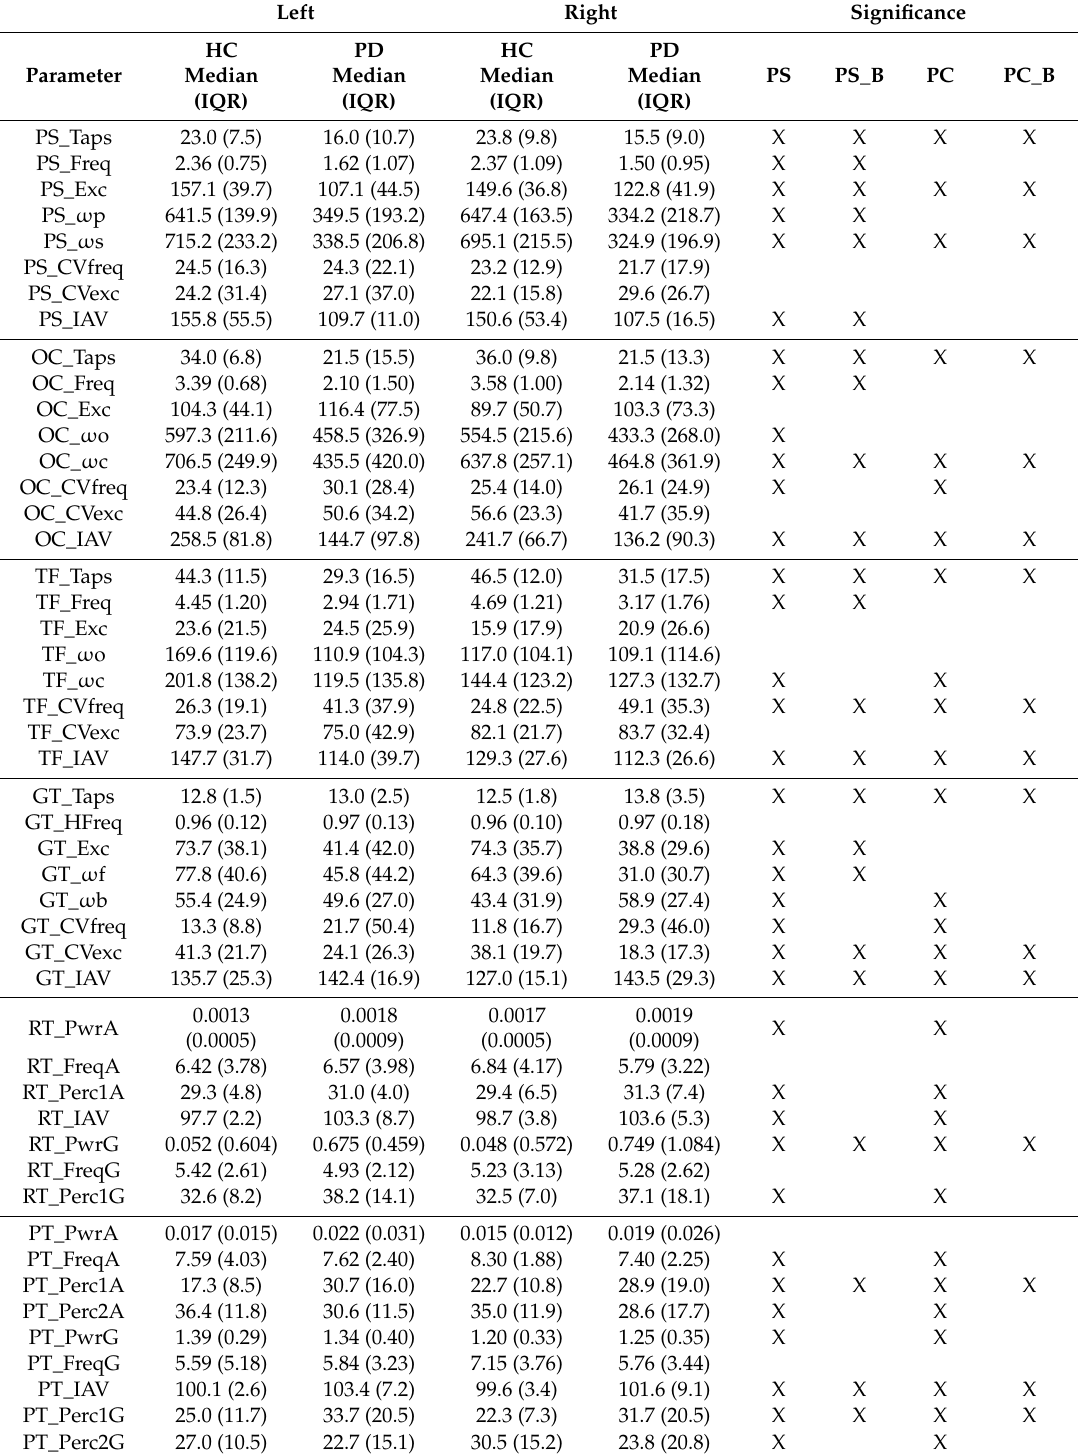
Table 4. Median and Interquartile Range (IQR) values for parameters extracted from upper limbs for both HC and PD. Significance of parameters in the four datasets (PS, PS_B, PC, PC_B) is marked. Left Right